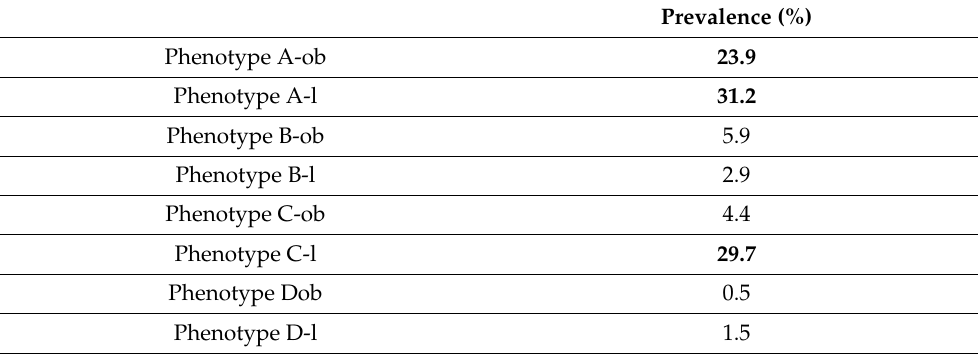
Table 2. Prevalence of different PCOS phenotypes in a Mediterranean population of PCOS women. Phenotypes were differentiated according to Rotterdam criteria (A phenotype: chronic anovulation, hyperandrogenism, polycystic ovaries; B phenotype: chronic anovulation, hyperandrogenism but normal ovaries; C phenotype: hyperandrogenism, polycystic ovaries but ovulatory cycles; D phe- notype: chronic anovulation, polycystic ovaries but normal androgens) and to finding of obesity (ob = obese) or normal body weight (l =